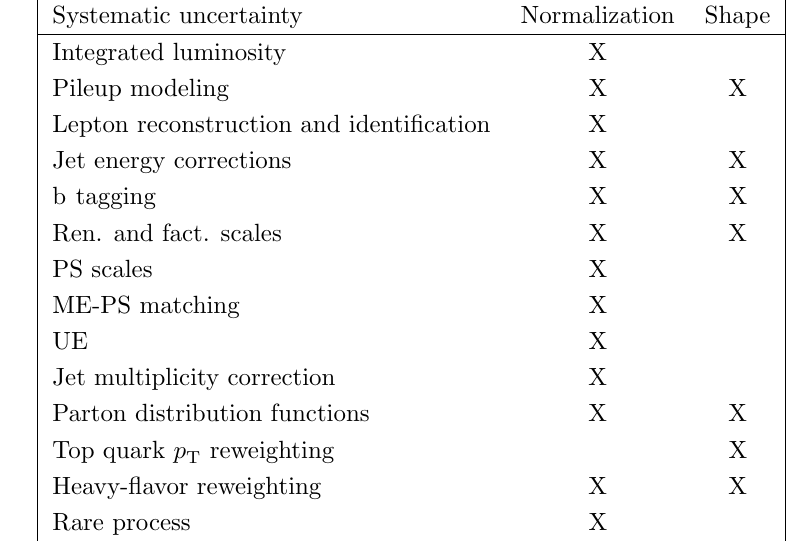
Table 1 . Uncertainties that a(cid:11)ect the normalization of the data sets and shapes of the D SL